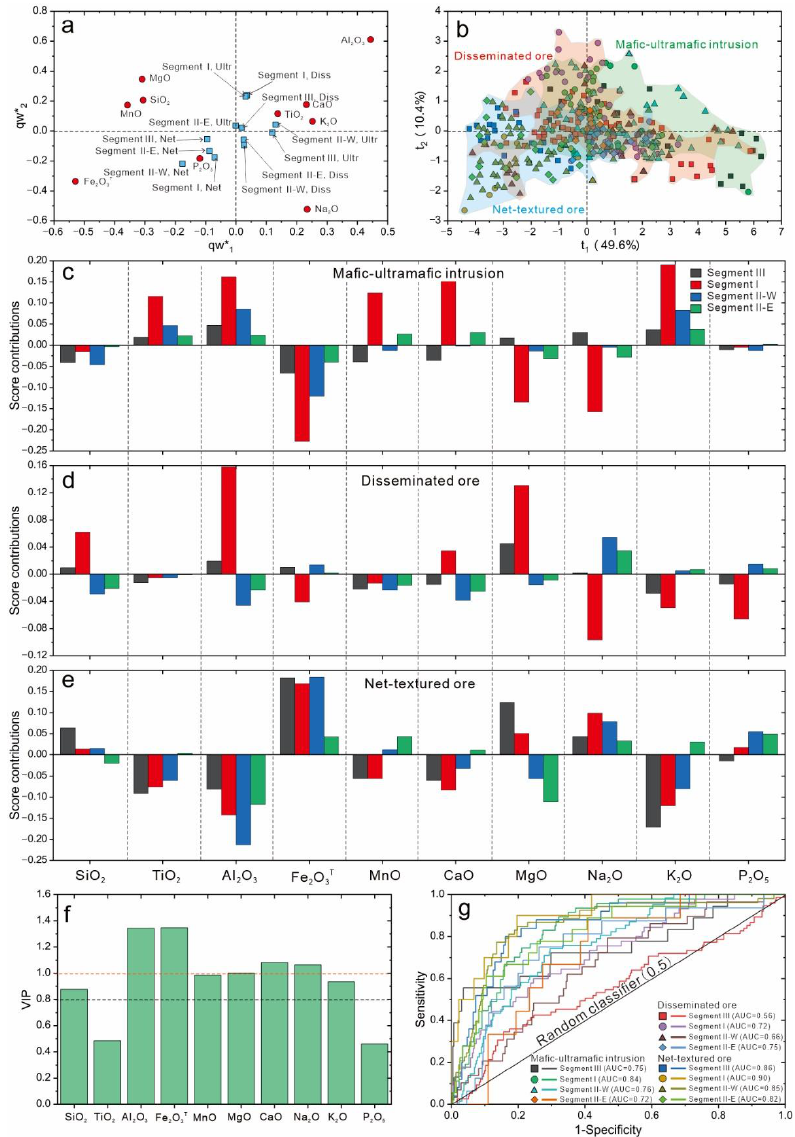
Figure 10. PLS-DA of whole-rock major element data for different ore types in each segment of the Jinchuan deposit. ( a ) The qw* 1 –qw* 2 loading plots. ( b ) The t 1 –t 2 score plots. The score contributions plots for ( c ) mafic–ultramafic intrusions, ( d ) disseminated ores, and ( e ) net-textured ores. ( f ) The VIP plots and ( g ) ROC curve. Ultr: mafic–ultramafic intrusions, Diss: disseminated ore, Net: net-textured